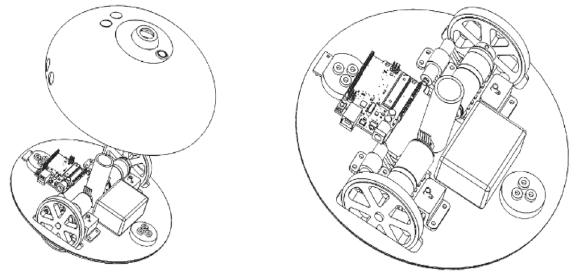
Figure 2: Dali internal layout and actuation